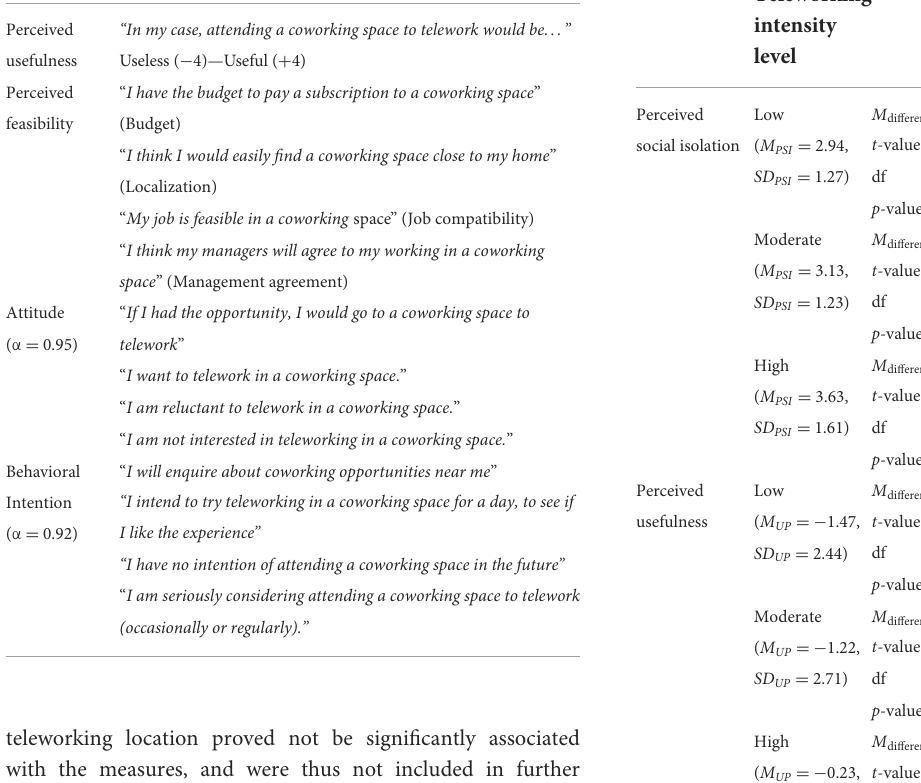
TABLE 4 Results of the post-hoc tests (Games-Howell) pertaining to the effect of teleworking intensity on perceived lack of social interaction, perceived usefulness, attitude, and behavioral